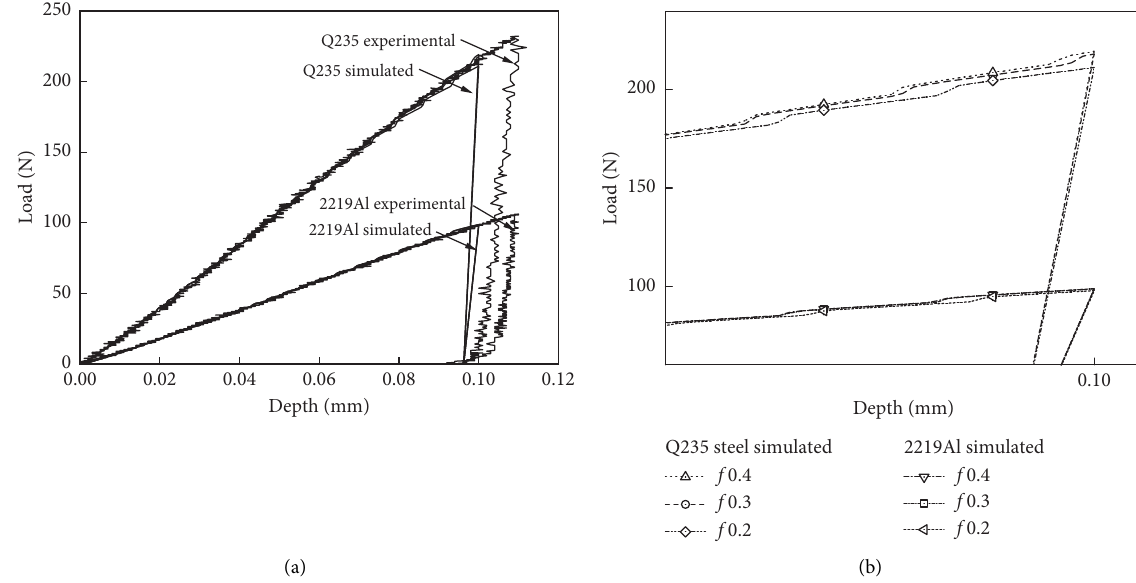
Figure 3: Comparison between experimental and numerical indentation curves of 2219Al alloy and Q235 steel: (a) the integral curve; (b) partial enlarged view.